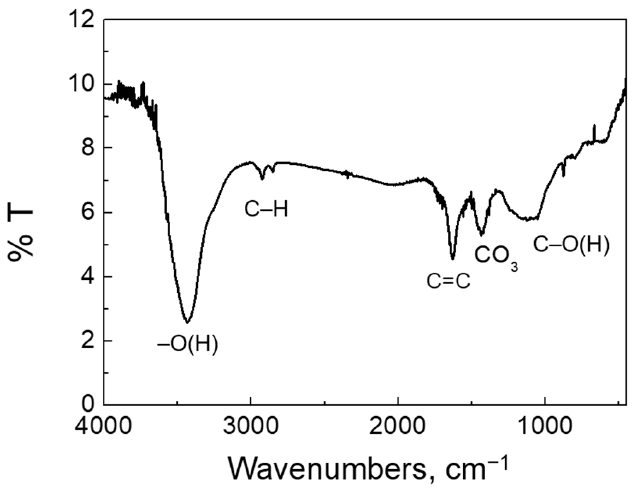
Figure 3. FTIR spectrum of biochar.